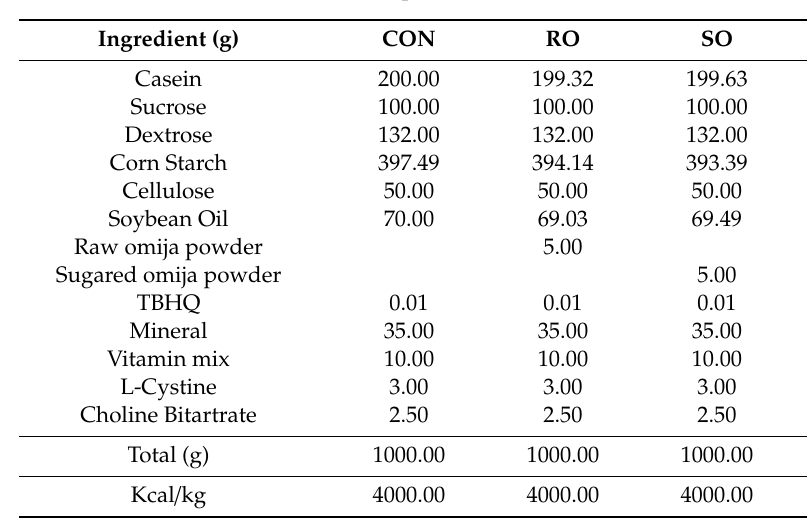
Table 1. Composition of